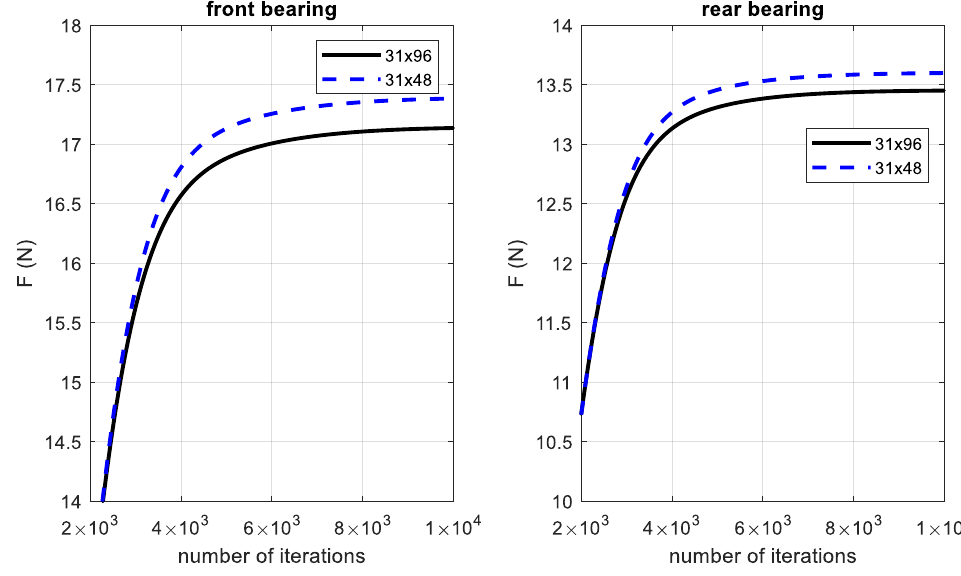
Figure 9. Load capacity vs. number of iterations obtained with different grid numbers along the circumferential direction.